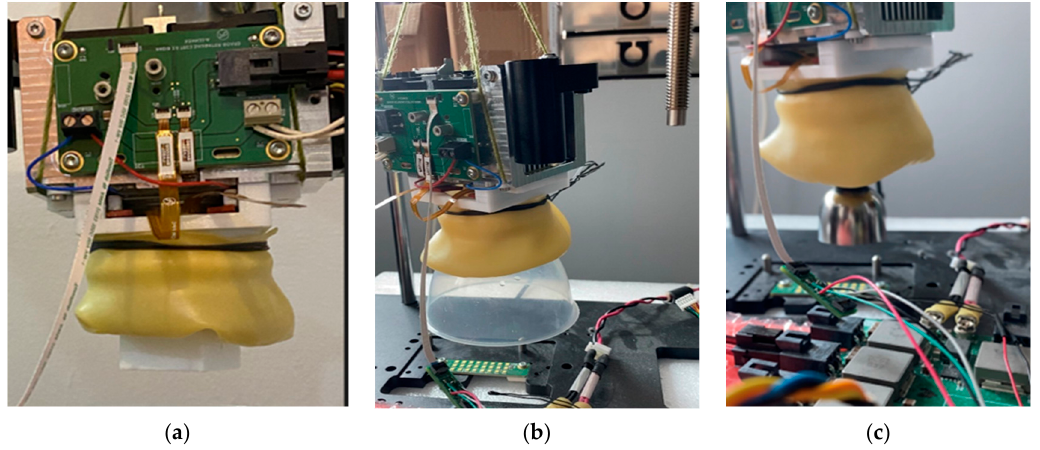
Figure 12. Liquid jamming gripper in action. Lifting ( a ) a cube; ( b ) plastic cup by base; ( c ) steel jigger.